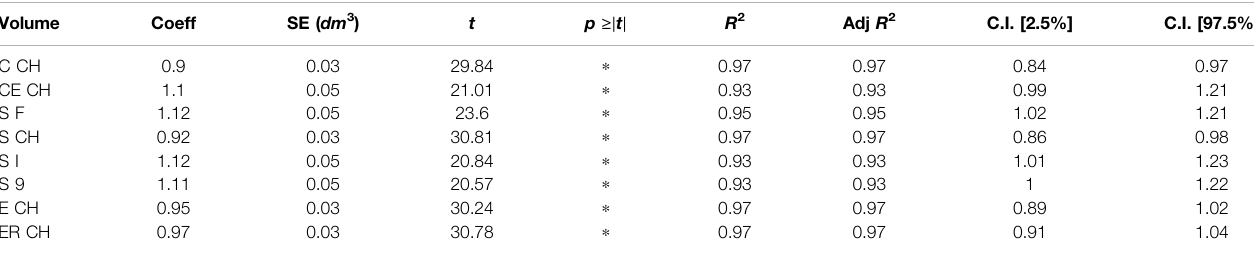
TABLE 3 | Linear regression models: digital volumes vs circumferential